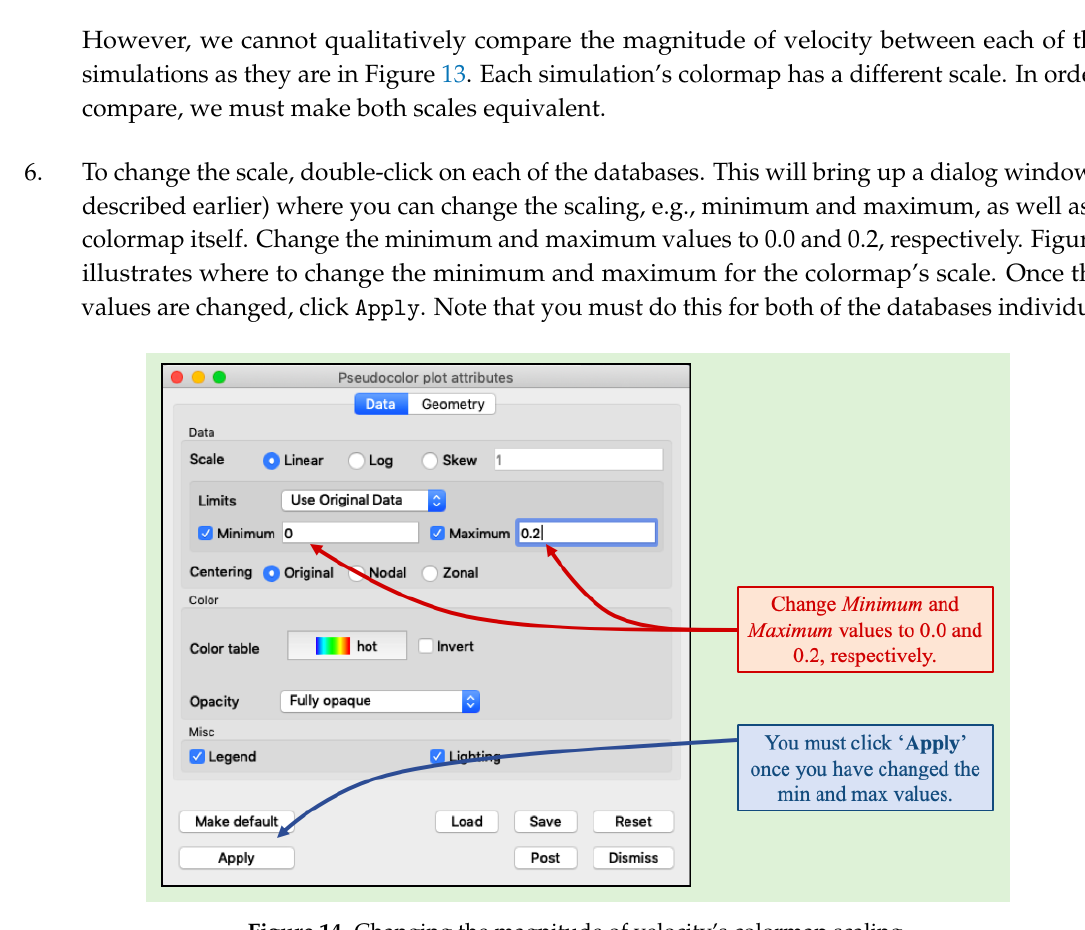
Figure 14. Changing the magnitude of velocity’s colormap scaling.